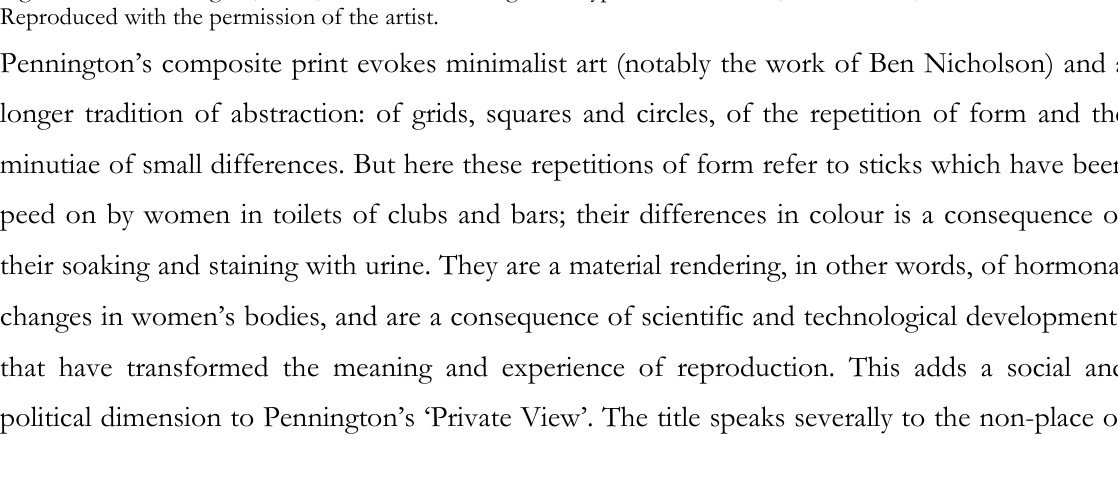
Culture of Childbirth Studies in the Maternal , 5 (2), 2013, www.mamsie.bbk.ac.uk